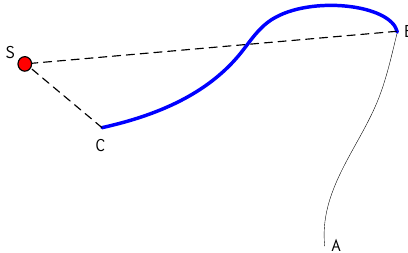
Figure 8. Sketch of the approaching effectiveness definition. The trajectory from A to B indicates the chemical-clue-finding phase, and B to C belongs to the plume tracing / traversal phase. The red point S stands for the chemical source. For our research, the plume tracing / traversal phase corresponds to the odor source searching with the ERP method and might include the chemical-clue-refinding phase.